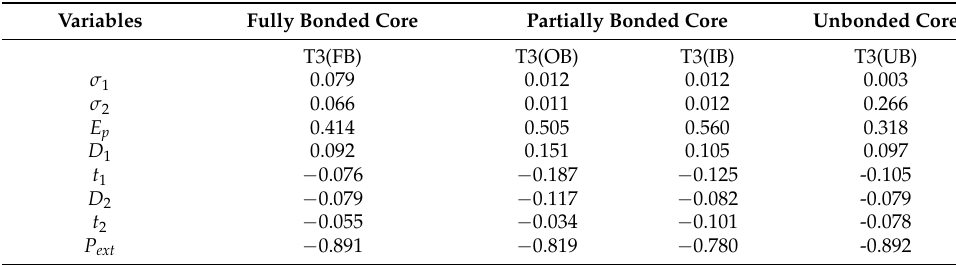
Table 5. Sensitivity factors ( α i ) for the basic variables for the SP